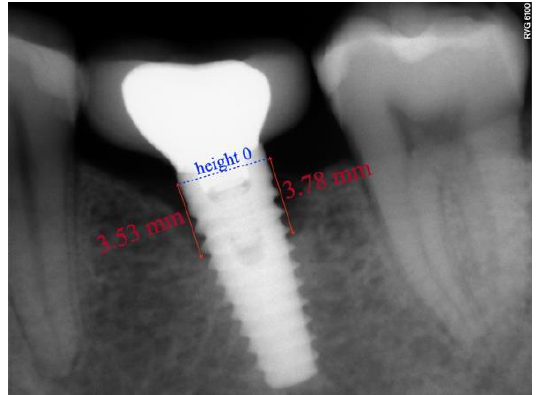
Figure 8. Periapical radiograph of a crestal implant (KOHNO) after 24 months of prosthetic loading. Values in red indicate the bone loss that has occurred.